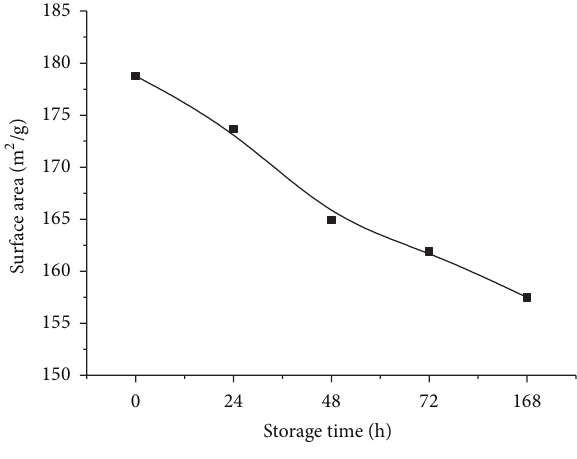
Figure 8: Effect of storage time of spent clay.